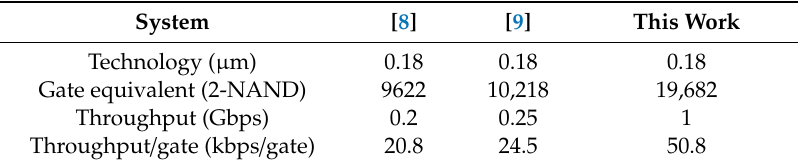
Table 2. Comparison with other chaotic stream